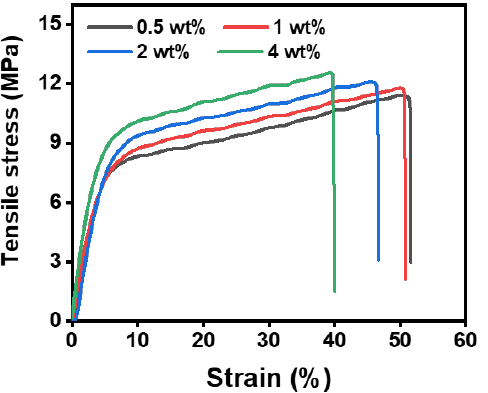
Figure 7. Stress – strain curves of PAN@AMP-1/MDI nanofibrous membranes modified with differ- Figure 7. Stress–strain curves of PAN@AMP-1/MDI nanofibrous membranes modified with different ent concentrations of MDI. concentrations of